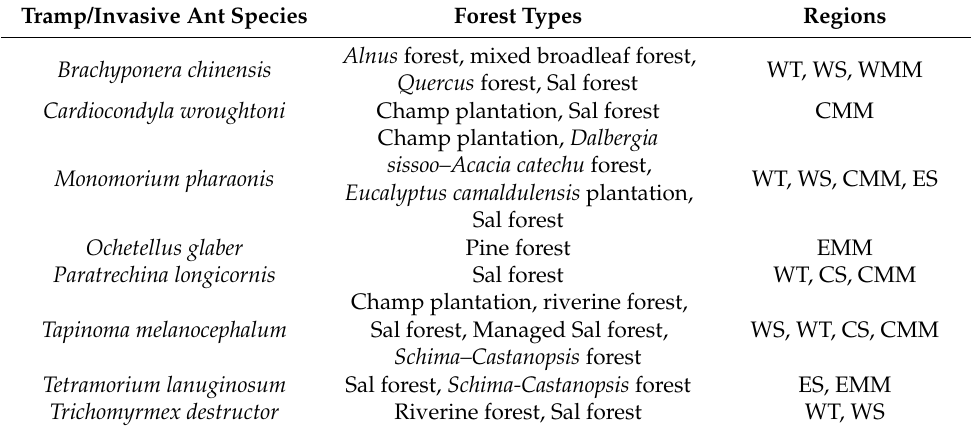
Table 3. Tramp/invasive ants occurring in different forest types and regions of Nepal. Tramp/Invasive Ant Species Forest